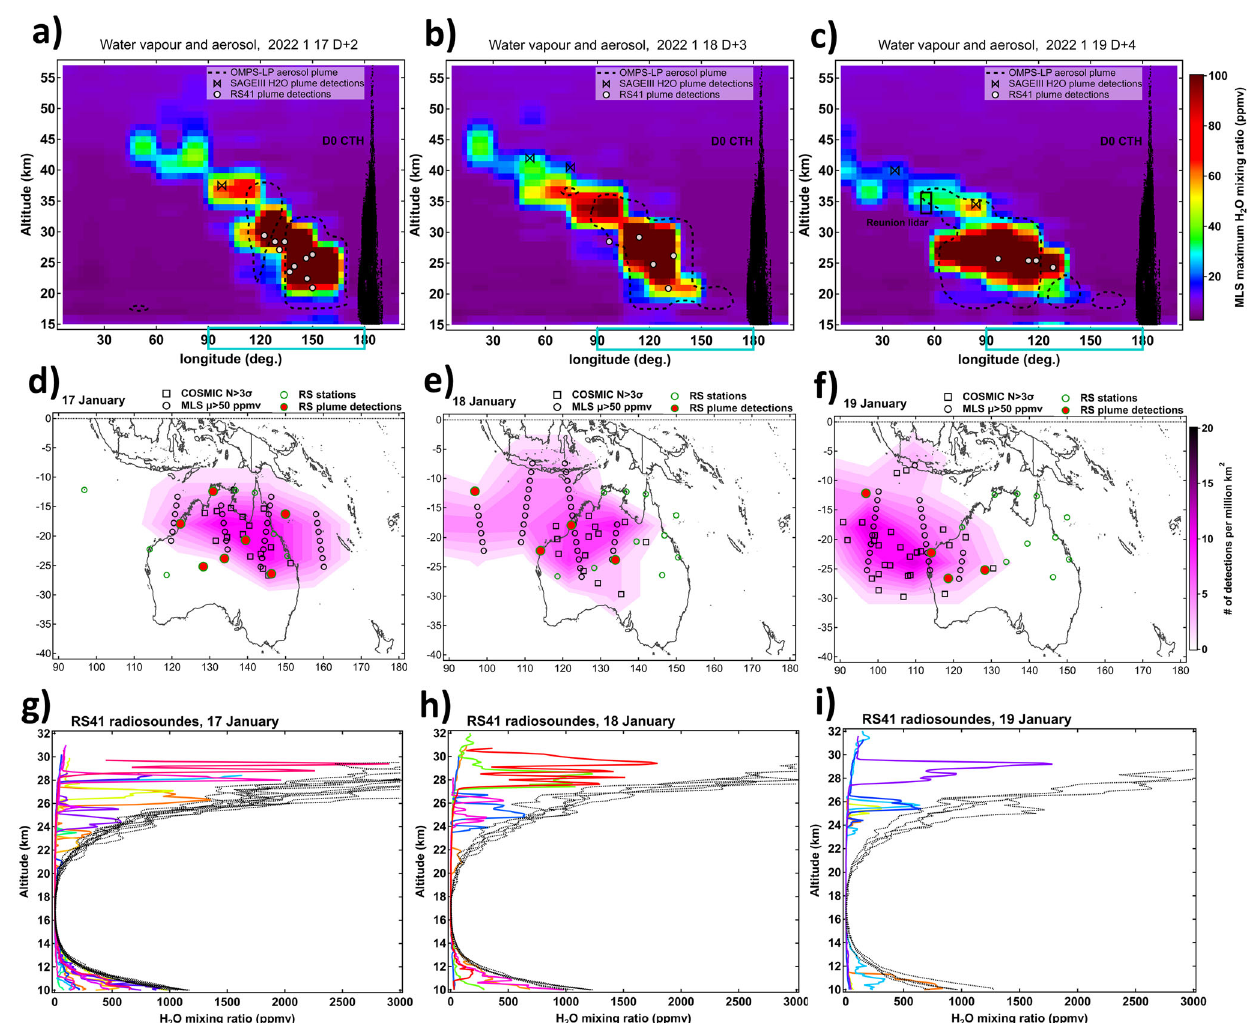
Fig. 2 Early evolution of volcanic plume during 17-19 January 2022 (D + 2 – D + 4). a – c Longitude-altitude section of MLS V4 maximum water vapour mixing ratio (WVMR) between 30° S – 10° S on the respective day. Black points indicate the ice cloud top height on the day of eruption (D0). The white curve represents zonally-averaged ECMWF zonal wind pro fi le. Black contours mark the areas where OMPS-LP detected aerosol layers with extinction ratio above 5. Diamonds and circles mark the detection of WVMR enhancements above 50 ppmv respectively by SAGE III and meteorological Vaisala RS41 radiosoundings. d – f Geographical extent of the hydrated plume within the 20 – 35 km layer reconstructed from MLS detections of WVMR > 50 ppmv (black circles) and COSMIC-2 refractivity anomalies indicative of hydrated layers (squares). The magenta color map shows the cumulative number of MLS and COSMIC-2 detections per million km 2 (computed using 3°×3° cells) on the given day. Locations of the Australian radiosounding stations are shown as green circles, the stations marked red represent the radiosonde detections of WVMR enhancements. g – i Radiosonde pro fi les bearing